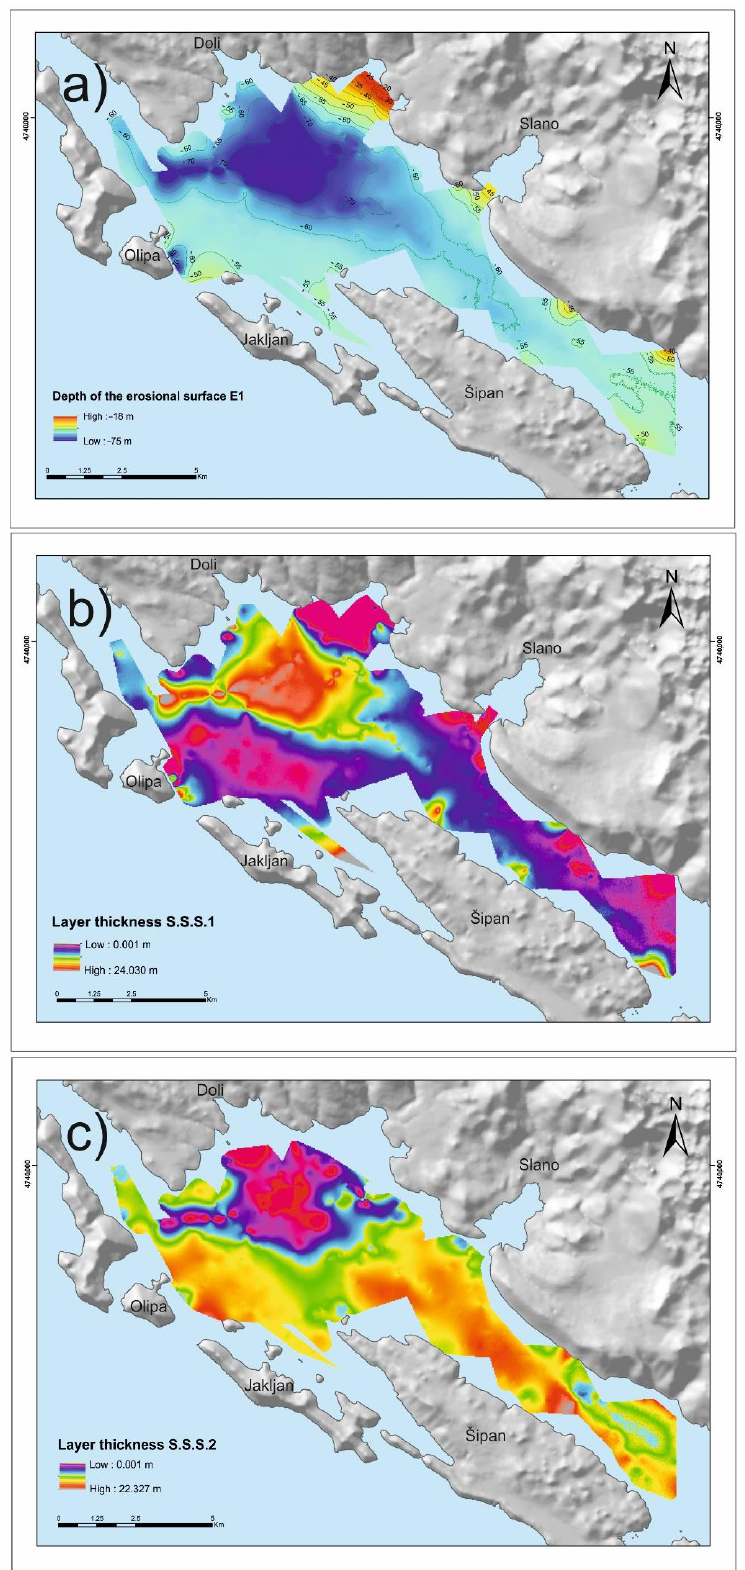
Figure 8. ( a ) Depth of the erosional surface E1, i.e., the surface of the seismostratigraphic sequence S.S.S.2, showing how the sediment basin looks before the deposition of S.S.S.1; ( b ) the layer thickness of seismostratigraphic sequence S.S.S.1.; ( c ) the layer thickness of seismostratigraphic sequence